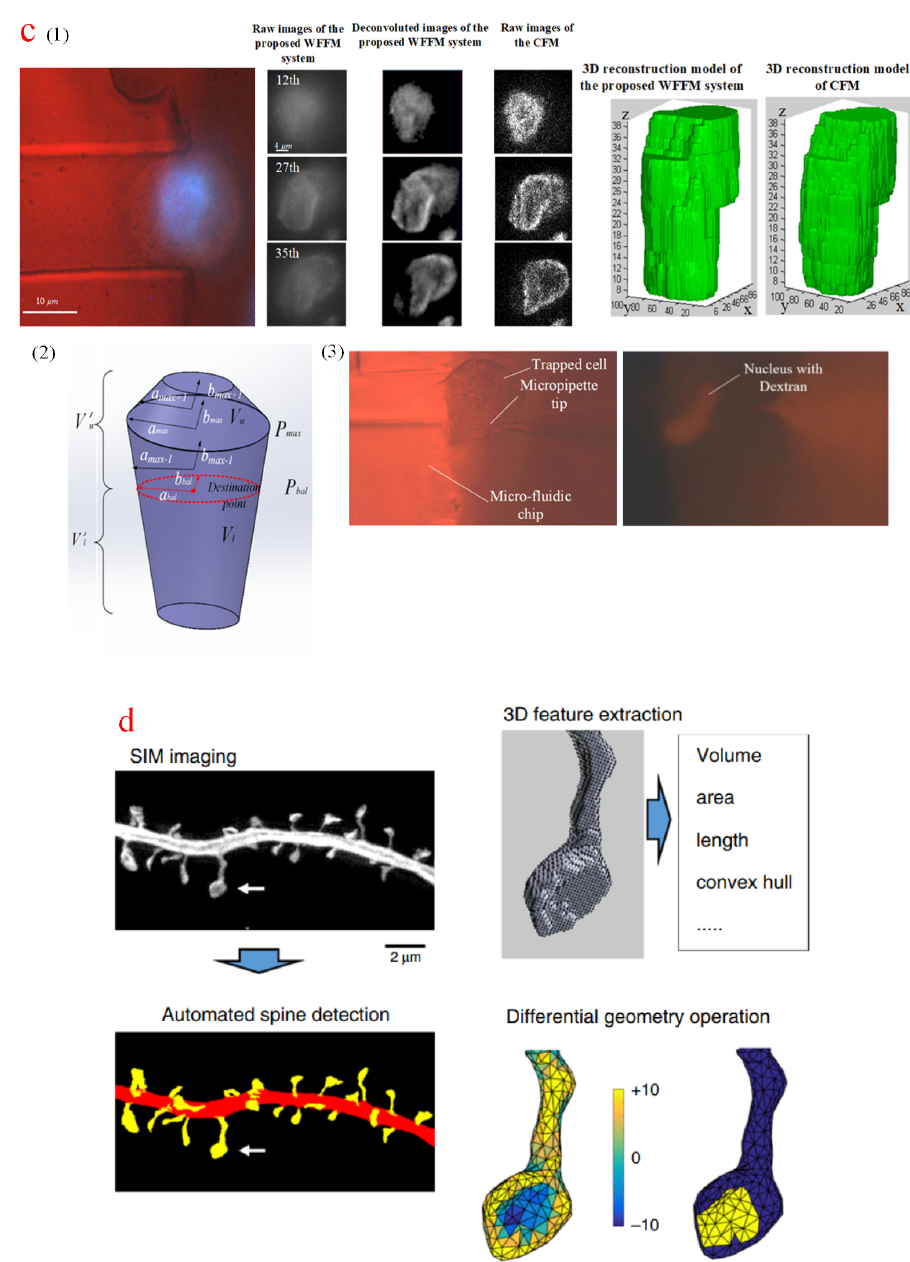
Figure 10. 3D analysis methods. ( a ) A reconstructed egg cell for microinjection inspection with the active snake node method. Adapted with permission from Reference [159]; ( b ) CFM-reconstructed 3D model of the nucleus of fibrosarcoma cells for the indentation test. Adapted with permission from Reference [164]; ( c ) 3D reconstruction with the WFFM images of the nucleus. (1) Reconstructed 3D model of WFFM and CFM. (2) Geometry analysis of the reconstructed model for intracellular delivery. (3) Successful nuclear delivery with 3D analysis information. Adapted with permission from Reference [165]; ( d ) 3D reconstruction with the SIM images of the spine neuron. Adapted with permission from Reference [166].